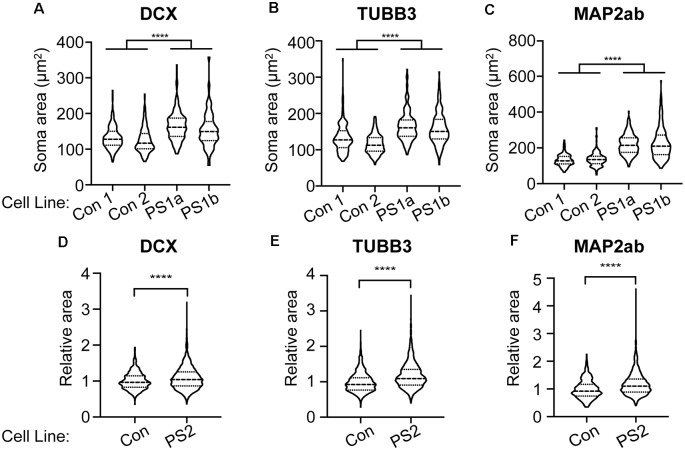
PS iPSC-derived neurons have larger soma compared to control neurons. Soma size was measured for each experimental group using markers for immature (DCX, TUBB3) and mature (MAP2ab) neurons. Violin plots with quartiles are displayed. (A–C) Two control cell lines (Con) and two cell lines from PS subject 1 were quantified from two independent neuronal differentiations, and the data for each genotype were combined. (A) Neurons labeled for DCX. Con n = 432 PS 1: n = 438. (B) Neurons labeled for TUBB3. Con: n = 426, PS 1: n = 431. (C) Neurons labeled for MAP2ab. Con: n = 433, PS 1: n = 434. (D–F) Neuronal differentiations were repeated using a separate control cell line (Con) and one cell line from PS subject 2 (PS 2). For each differentiation, soma size was normalized to the control neurons to account for batch to batch variation. Two independent neuronal differentiations were quantitated for DCX (D) and four independent differentiations were quantitated for TUBB3 (E) and MAP2ab (F). (D) Neurons labeled for DCX. Con: n = 563, PS 2: n = 1,711. (E) Neurons labeled for TUBB3. Con: n = 866, PS 2: n = 2,430. (F) Neurons labeled for MAP2ab. Con: n = 430, PS 2: n = 1,944. Statistical analysis was performed using an unpaired Student’s t-test with Welch’s correction. ****p < 0.0001.